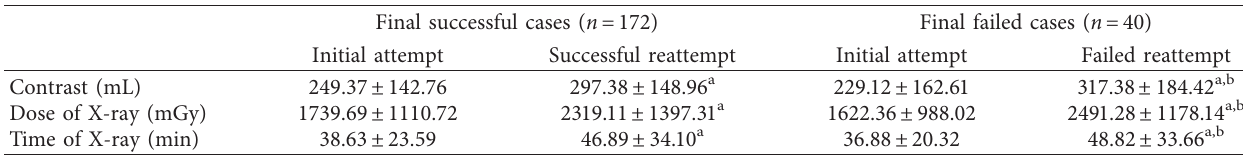
Table 4: Contrast and radiation differences.